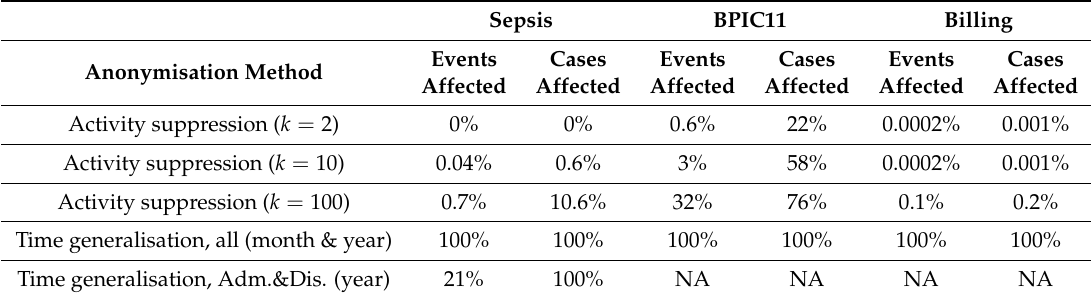
Table 3. The percentage of cases and events affected by the application of activity suppression and time generalisation to the three event